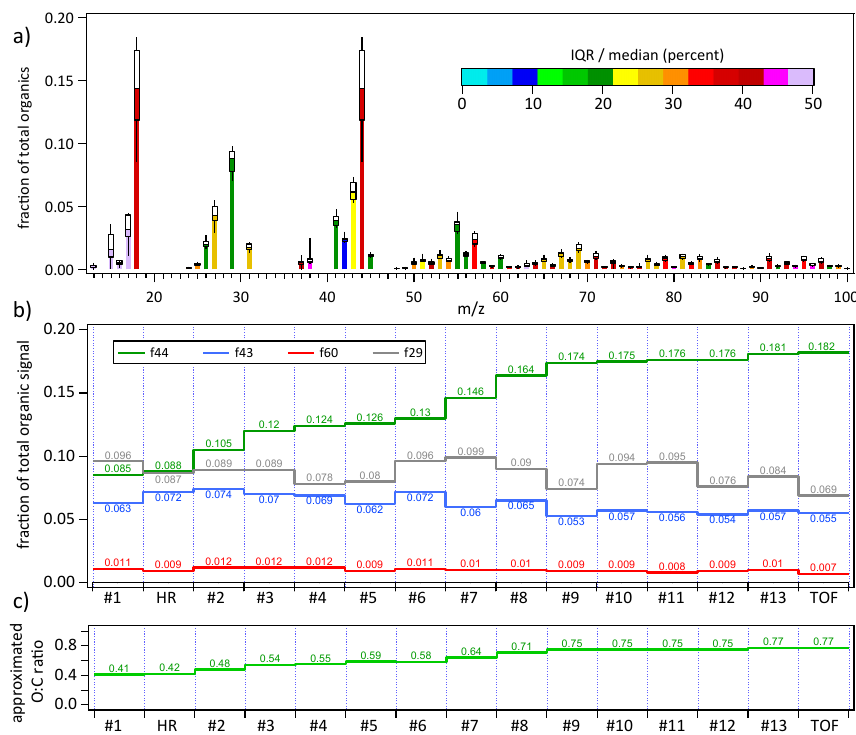
Figure 2. (a) Median organic mass spectrum of the 13 Q-ACSMs (sticks) during interruption-free 20h period (average of ∼ 1200 mass spectra). The boxes represent the interquartile range for each m/z stick and the whiskers represent the corresponding full range over all instruments. The line in the box indicates the median. The colour bar represents the ratio of the width of the individual boxes in relation to the corresponding median in percent. (b) Fractions of the total organic signal at single m/z channels for all 15 participating instruments sorted by fraction of m/z 44. Grey: f 29 , blue: f 43 , green: f 44 , red: f 60 . The respective fractions are given as numbers in the same colours. (c) O:C ratio calculated via the formula given in Aiken et al. (2008) for all 15 participating instruments sorted by f 44 . O:C values are also given as